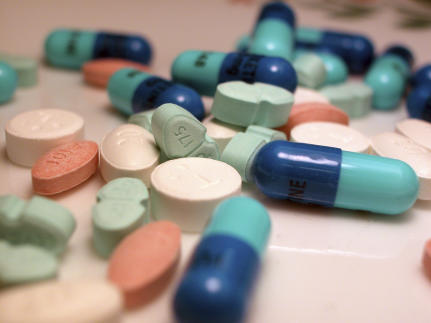
Pills are often marketed as a solution to human anxieties and dissatisfactions